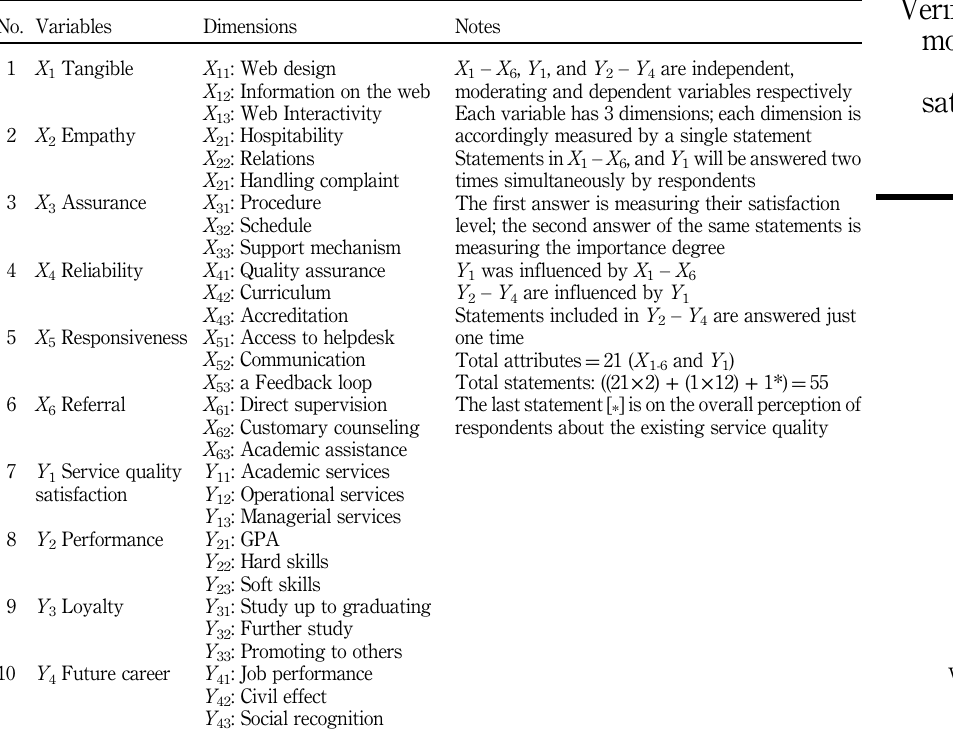
Table 1. Variables and dimension of the